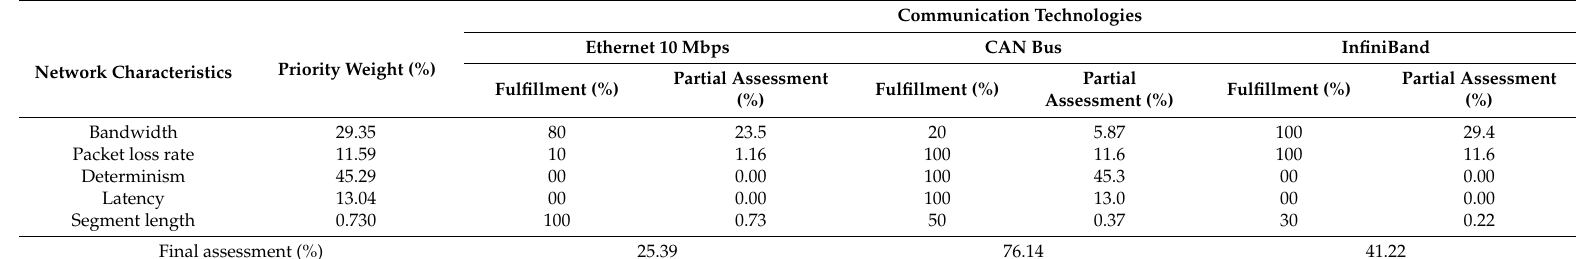
Table 14. Example assessment according to the cost-benefit analysis